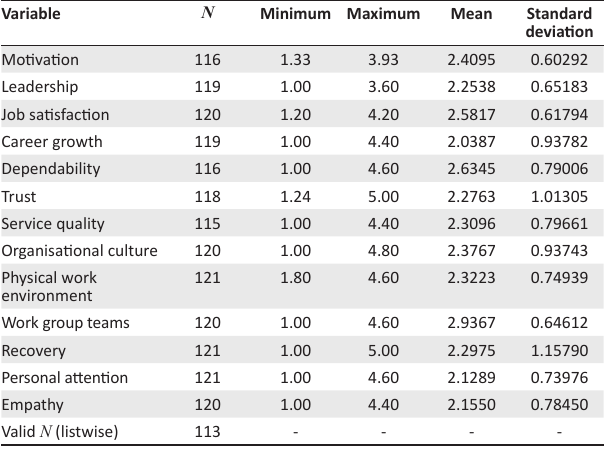
TABLE 1: Descriptive statistics of study variables.